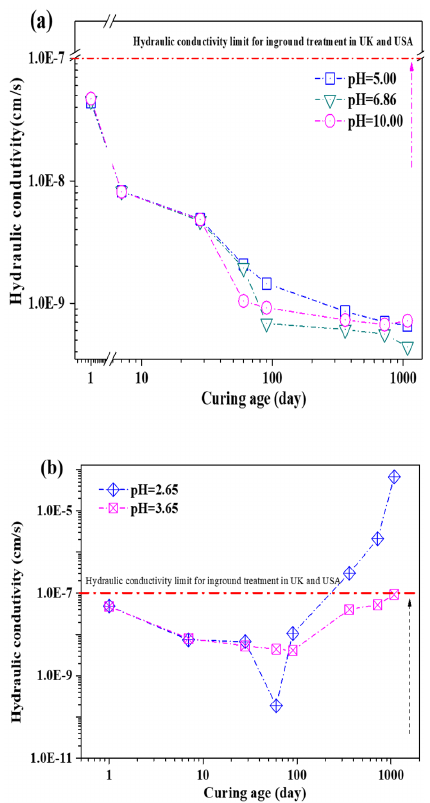
Figure 3. Hydraulic conductivity variation over3 years of immersion: ( a ) weakly acidic and weakly alkaline environments; ( b ) strongly acidic environments. Table 2. Fitting results for hydraulic conductivity under different pH conditions.